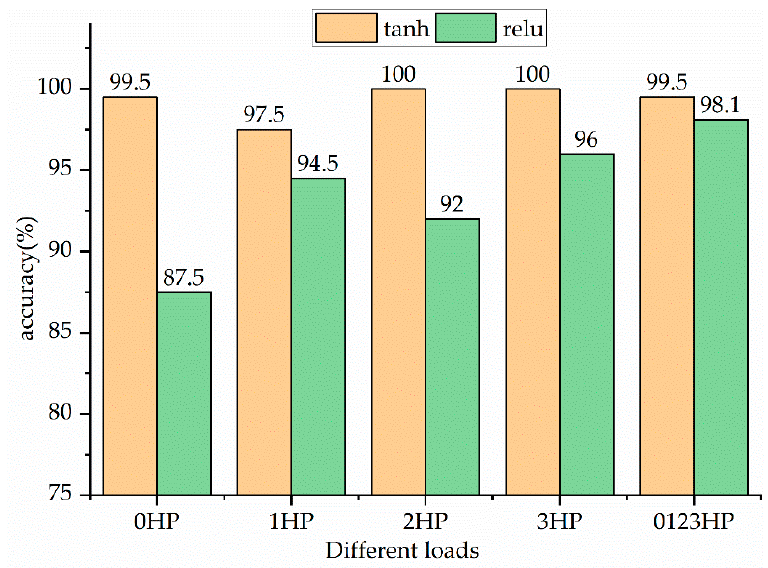
Figure 9. The influence of different activation functions on accuracy under different loads.